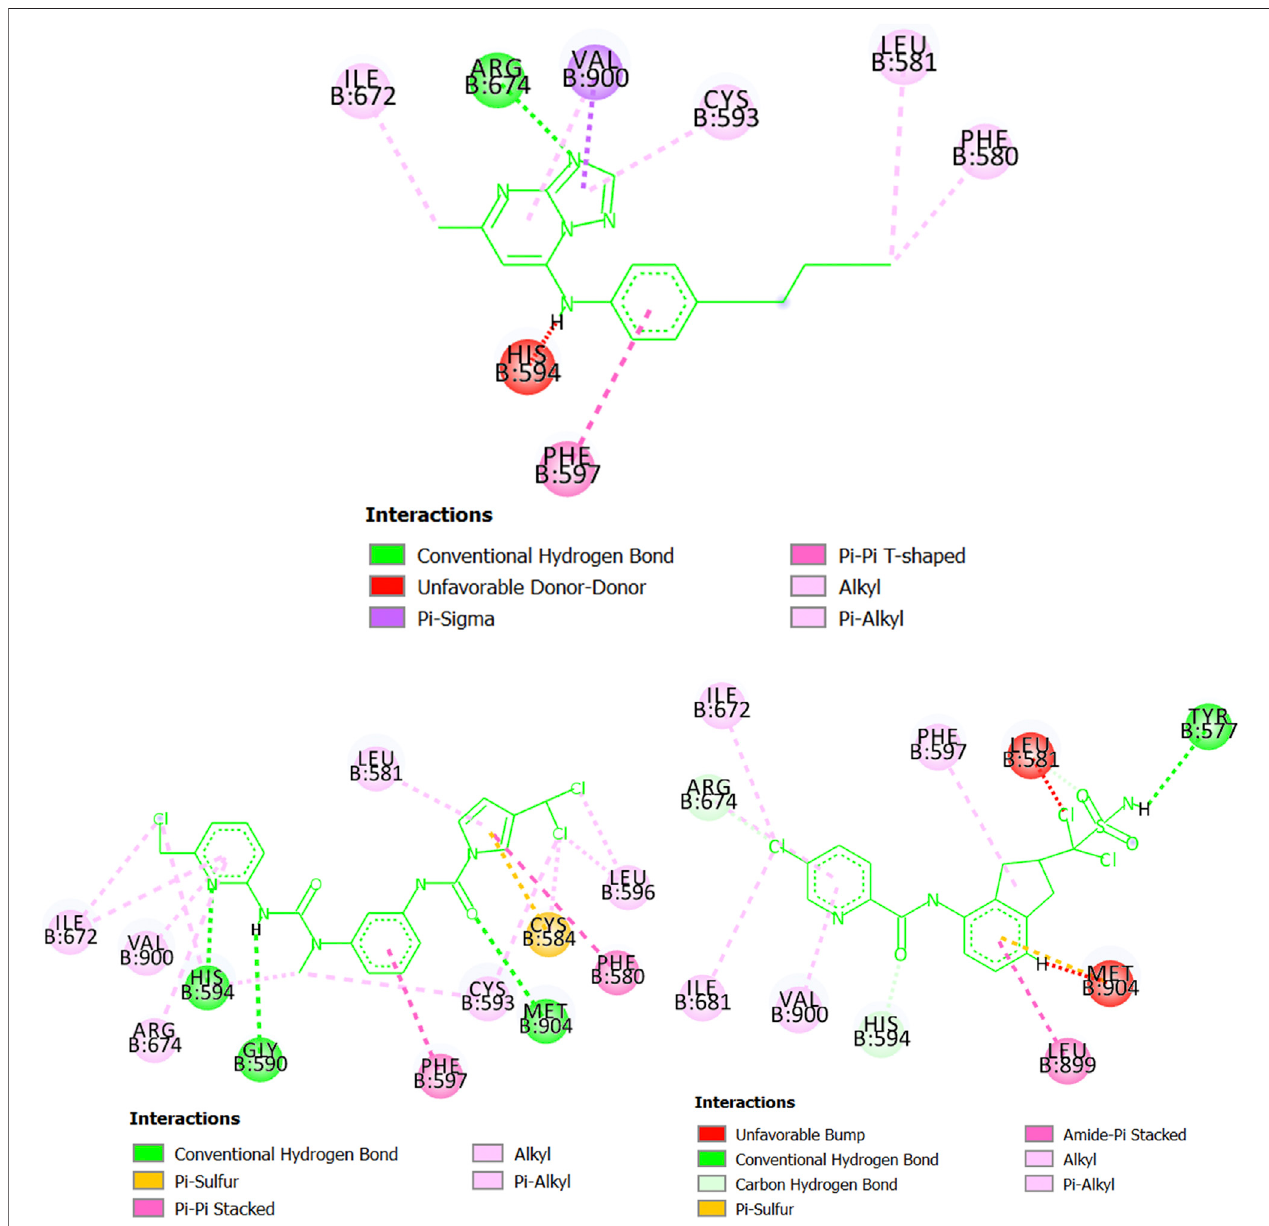
FIGURE 7 | Diagram depicting the interactions of CHEMBL1784557 (top center) , MTIPP-002 (left bottom) and MTIPP-004 (right bottom) with dihydroorotate dehydrogenase ( P. falciparum ).